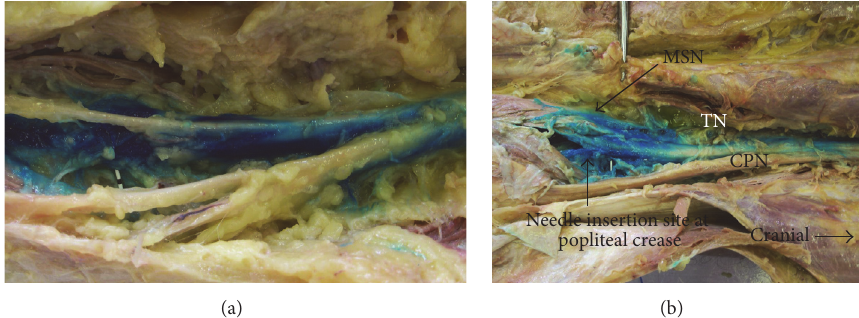
Figure1:Bluedyeinjectedaroundthetibialnerveatthepoplitealcrease.(a)Spreadofbluedyeisobservedwithsignificantextensionproximal to the bifurcation point of the sciatic nerve. Complete sparing of the common peroneal nerve is observed at the level of the popliteal crease, (b) MSN = medial sural nerve; TN = tibial nerve; CPN = common peroneal nerve; SN = sciatic nerve.